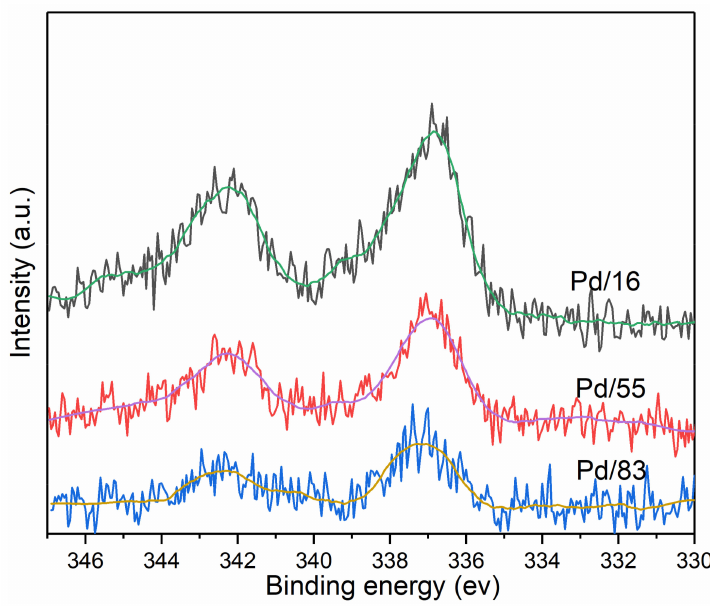
Figure 6. Pd3d X-ray photo electron spectroscopy (XPS) spectra of each